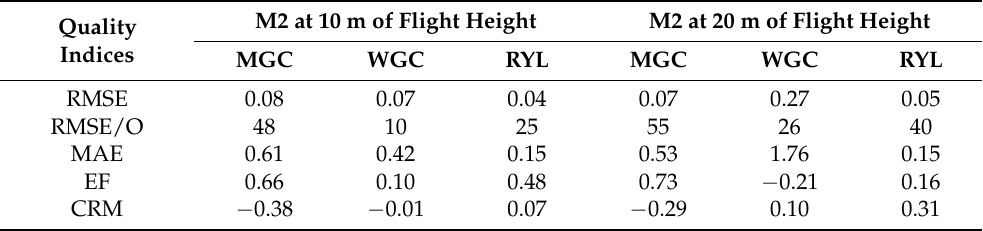
Table 6. Modelling quality indices (RMSE, RMSE/ ¯O, MAE, EF and CRM for more details see Table 1) used to evaluate the goodness of fit for method 2 (M2) at 10 and 20 m of flight height in estimating the maize green cover (MGC), the weed green cover (WGC) and relative yield loss (RYL). M2 at 10 m of Flight Quality Indices